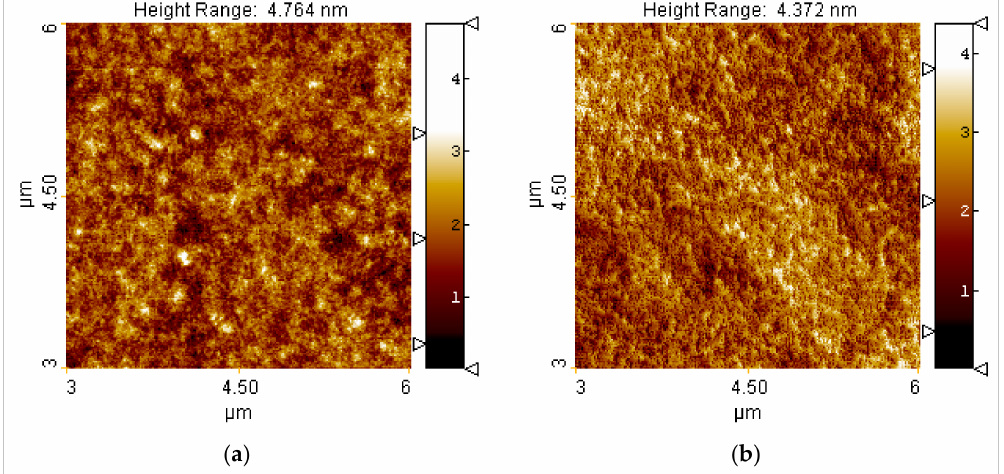
Figure 4. Examples of AFM acquired images of the PC surface: (a) Untreated and (b) treated using 620 W of microwave